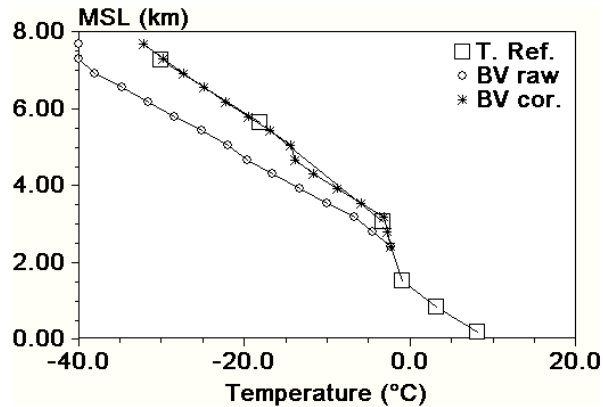
Fig. 11. Temperature profiles obtained from the B-V measurements using peak frequency (BV raw) from Fig. 6, and a factor correction on the frequency (BV cor.), compared to the reference temperature profiles provided by the analysis output from the ECMWF model (T.